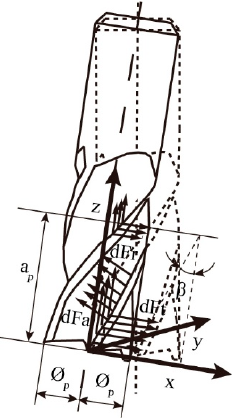
Figure 8. Infinitesimal milling modeling of end